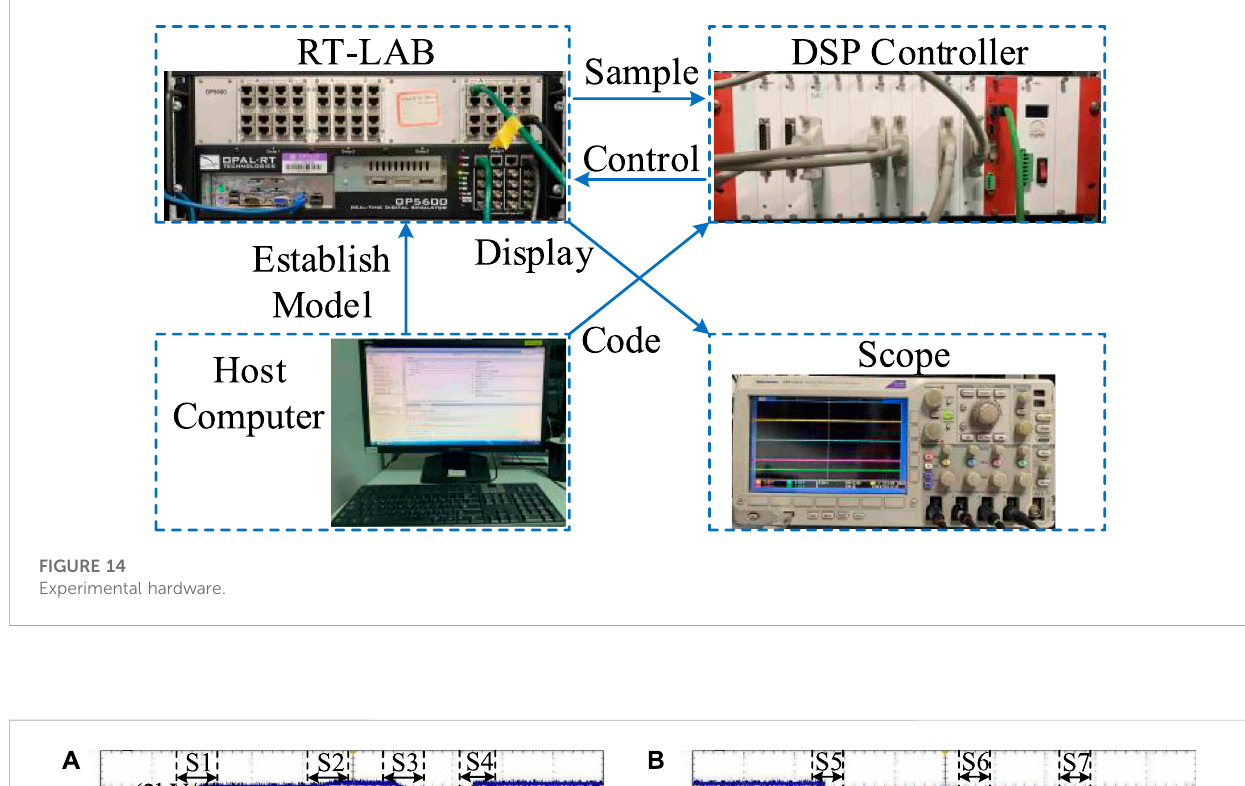
FIGURE 14 Experimental hardware.